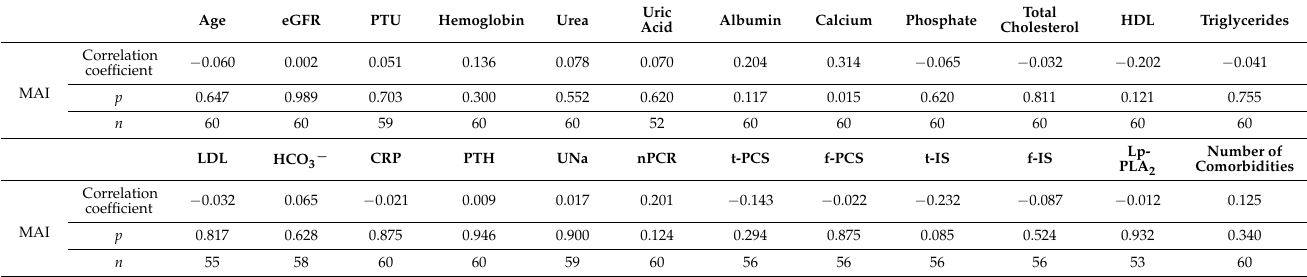
Table 4. Correlation table.